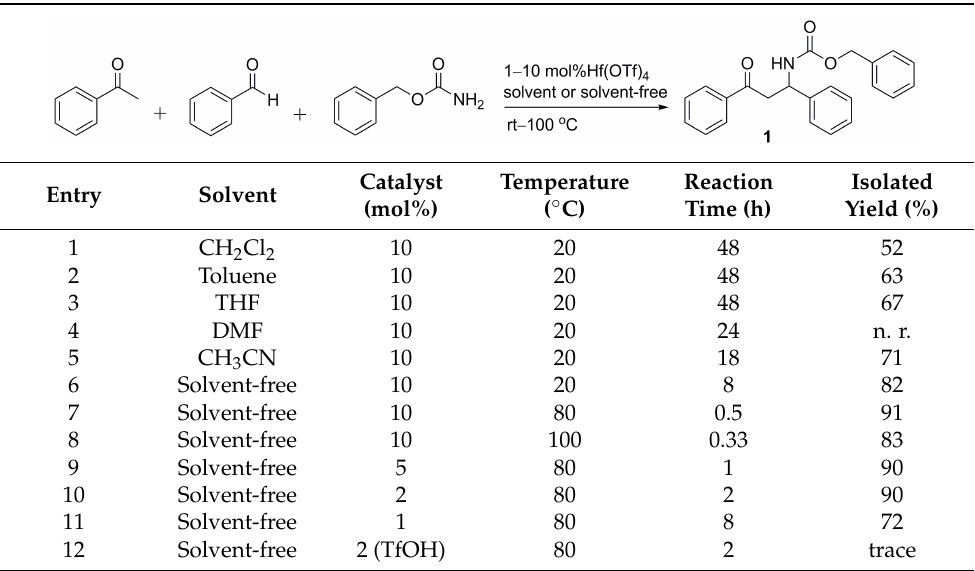
Table 2. Effects of solvent, temperature, and amount of catalyst loading on the three-component synthesis of 1 1 .